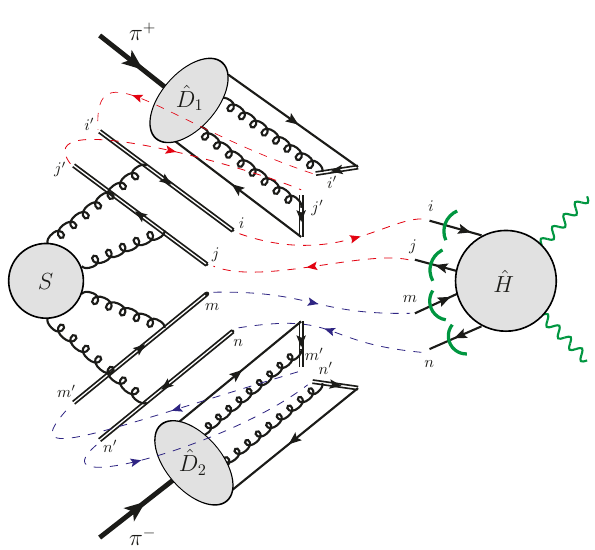
Figure 9. The result of using Ward identity for attachments of soft gluons to ˆ D 1 and ˆ D 2 . The Wilson lines are in fundamental 3 or ¯ 3 color representation. The Wilson lines on ˆ D 1 side come from the past along n 1 , and those on ˆ D 2 side come from the past along n 2 . The red and blue dashed lines indicate the color flow among collinear, soft and hard subgraphs. i, j, m, n, i 0 , j 0 , m 0 , n 0 are the color